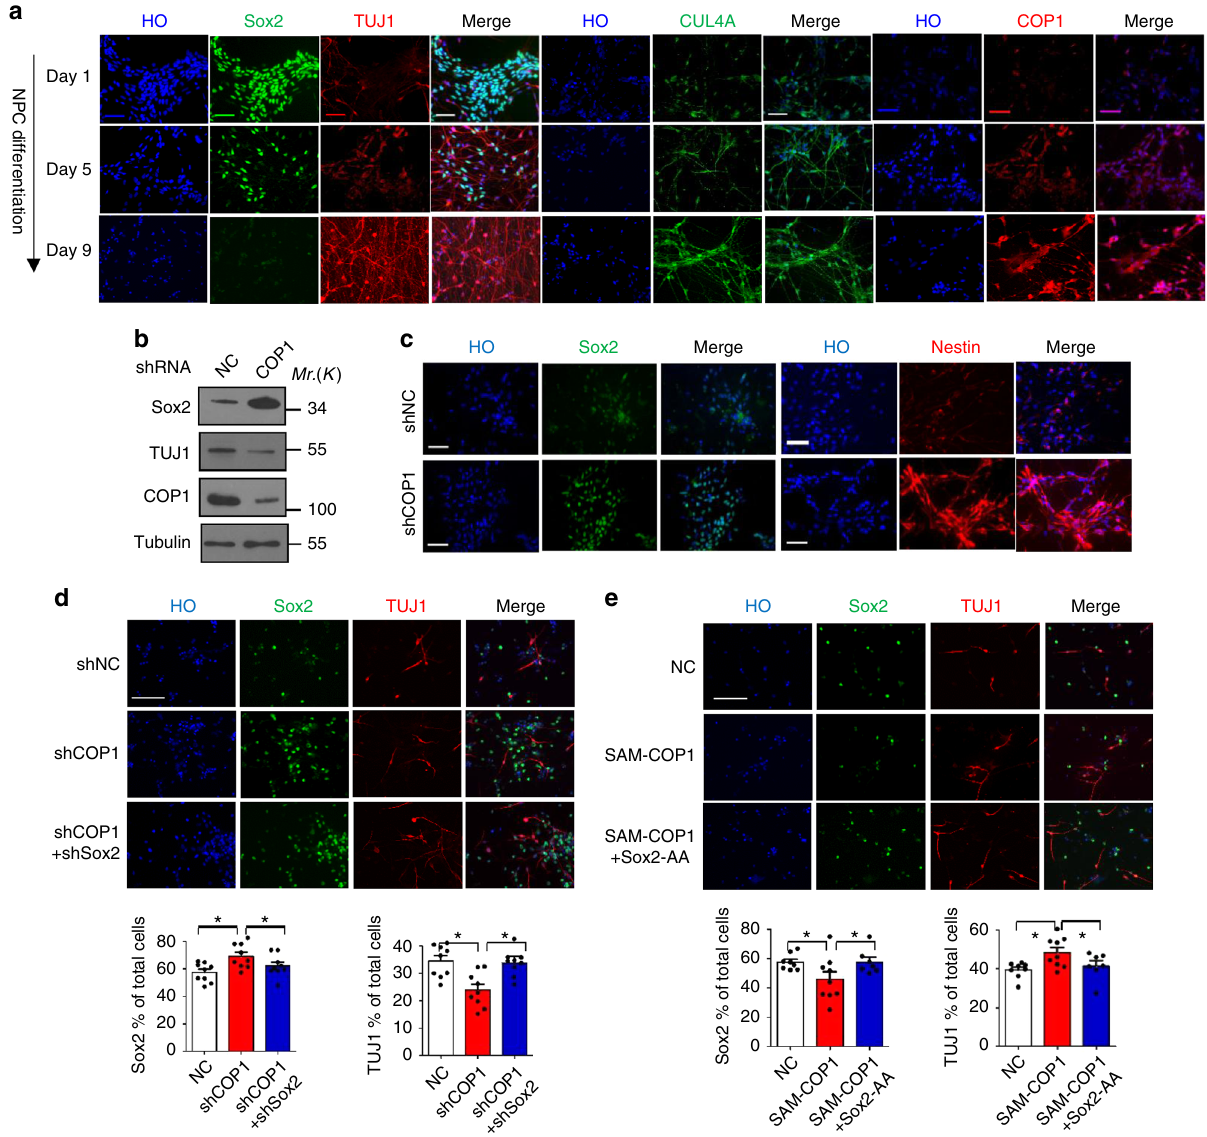
Fig. 5 COP1 promotes NPCs differentiation in a Sox2-dependent manner. a NPCs were plated in Matrigel-coated six-well plate for neuronal differentiation. For the indicated times, fi xed and stained with anti-Sox2 (green), anti-COP1 (red), anti-TUJ1 (red), or CUL4A (green)-speci fi c antibodies. Nuclei were counterstained with Hoechst 33342 (HO, blue). Scale bar, 50 µ m. b , c NPCs were infected with lentiviruses expressing COP1 shRNA or negative control (NC) shRNA for 126 h. Immunoblotting ( b ) and immunostaining ( c ) were performed for Sox2, COP1, TUJ1, or Nestin. Scale bar, 50 µ m. d NPCs with double knockdown of COP1 and Sox2 were generated by lentivirus infection. Immunostaining were performed for Sox2, TUJ1. Scale bar, 50 µ m. The ratio of TUJ1- positive or Sox2-positive cells were quanti fi ed. Results are shown as mean ± s.d. Each error bar shows the standard deviation of numbers of positive cells in 10 fi elds of view. * P < 0.05, Student ’ s t -test. e NPCs with co-expression of COP1 and Sox2-AA were generated by lentivirus infection. Cas9-based activator of COP1 (SAM-COP1) were used to activate COP1 expression in NPCs. Immunostaining were performed for Sox2 and TUJ1. Scale bar, 50 µ m. The ratio of TUJ1-positive or Sox2-positive cells were quanti fi ed. Results are shown as mean ± s.d. Each error bar shows the standard deviation of numbers of positive cells in 10 fi elds of view. * P < 0.05, Student ’ s t -test. The representative images are shown from three independent experiments. Unprocessed original scans of blots are shown in Supplementary Fig. puri fi ed recombinant GST-tagged OTUD7B truncates, including GST-OTUD7B-N (1-359), GST-OTUD7B-C (360 – 843), GST- OTUD7B- △ ZF (1 – 810), and GST-OTUD7B-ZF (811 – 843) (Fig. 6g). The result of GST pull-down assay indicated that Sox2 interacted with OTUD7B ZF domain directly in cell-free system (Fig. 6g).